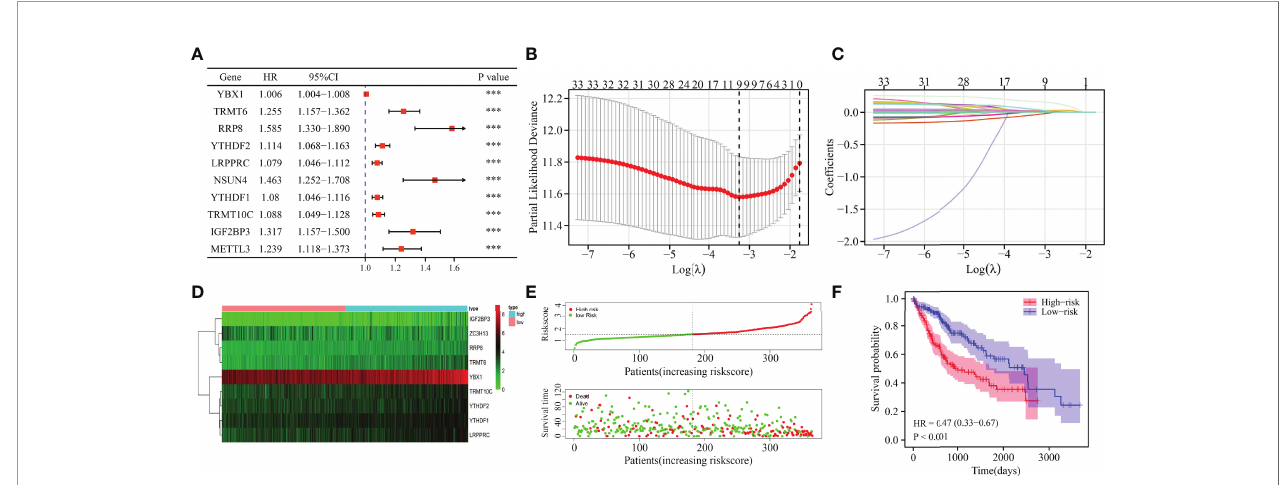
FIGURE 5 | The risk model constructed using the LASSO method for predicting the prognosis of patients. (A) Cox method showing the prognostic value of m6A/ m1A/m5C regulated genes. (B, C) The 9 m6A/m5C/m1A-regulated genes identi fi ed using least absolute shrinkage and LASSO method. (D – F) The association of high-risk score with the m6A/m1A/m5C regulated genes and prognosis of HCC patients. HCC, hepatocellular carcinoma; LASSO, least absolute shrinkage and selection operator; ***P <